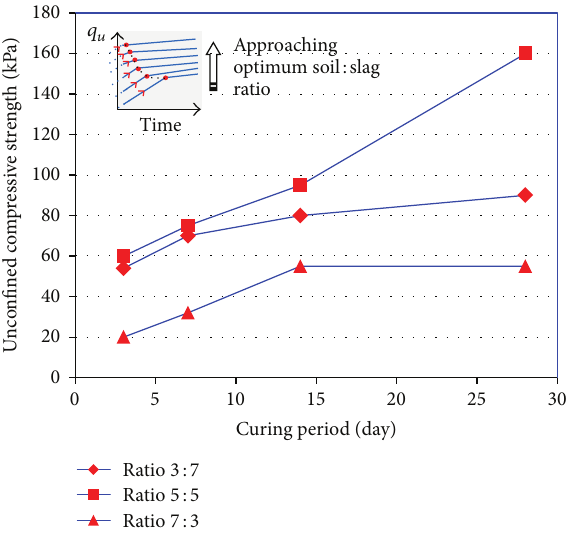
Figure 5: 𝑞 𝑢 -curing